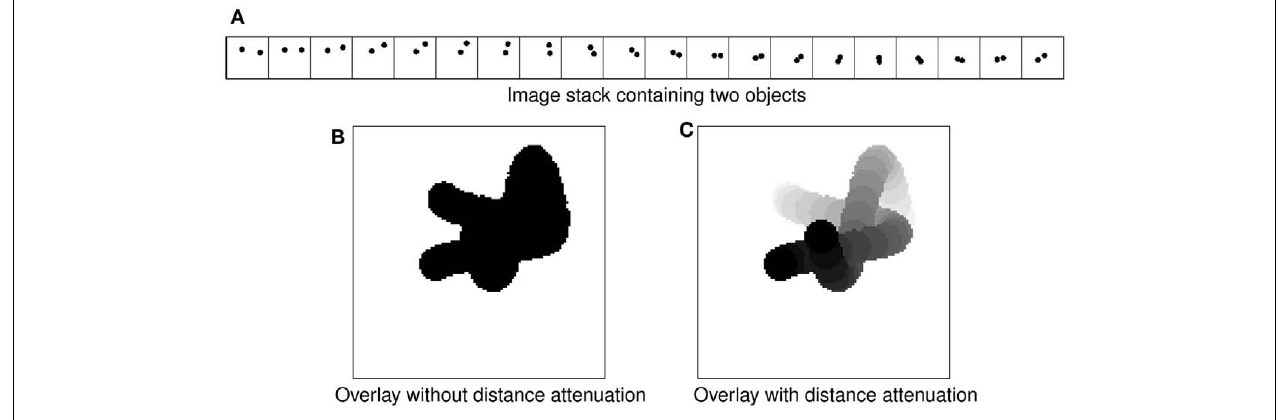
FIGURE 2 |Transparent overlay with distance attenuation. (A) An image stack containing two intertwined objects are shown. (B) Simple overlay of the image stack in (A) results in loss of 3D perspective. (C) Overlay with distance attenuation helps bring out the 3D